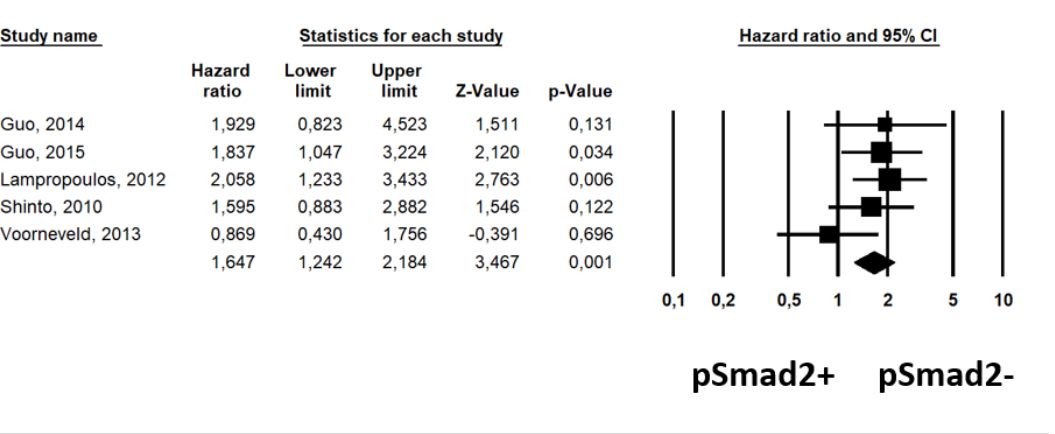
Figure 2. Forest-plot of relative risk of all-cause mortality: patients with pSmad2- have an increased risk of all-cause mortality, statistically significant ( p = 0.029).